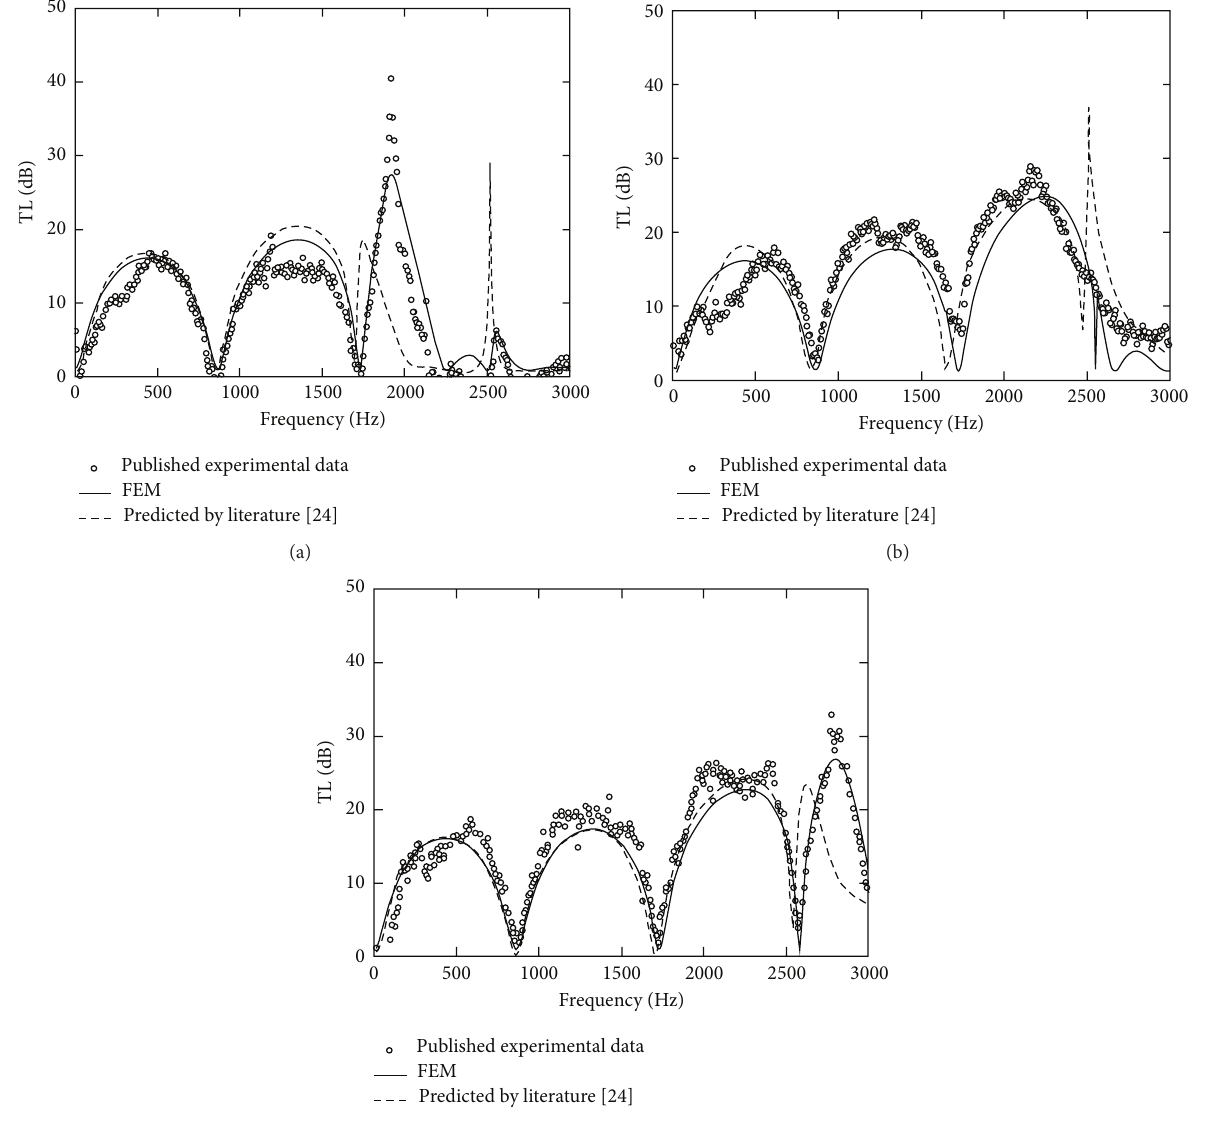
Figure 12: Measured and predicted TL for the straight-through perforated pipe silencers: (a) silencer 𝑃 1 , 𝑀 = 0.1 , (b) silencer 𝑃 2 , 𝑀 = 0.2 , and (c) silencer 𝑃 3 , 𝑀 = 0.1